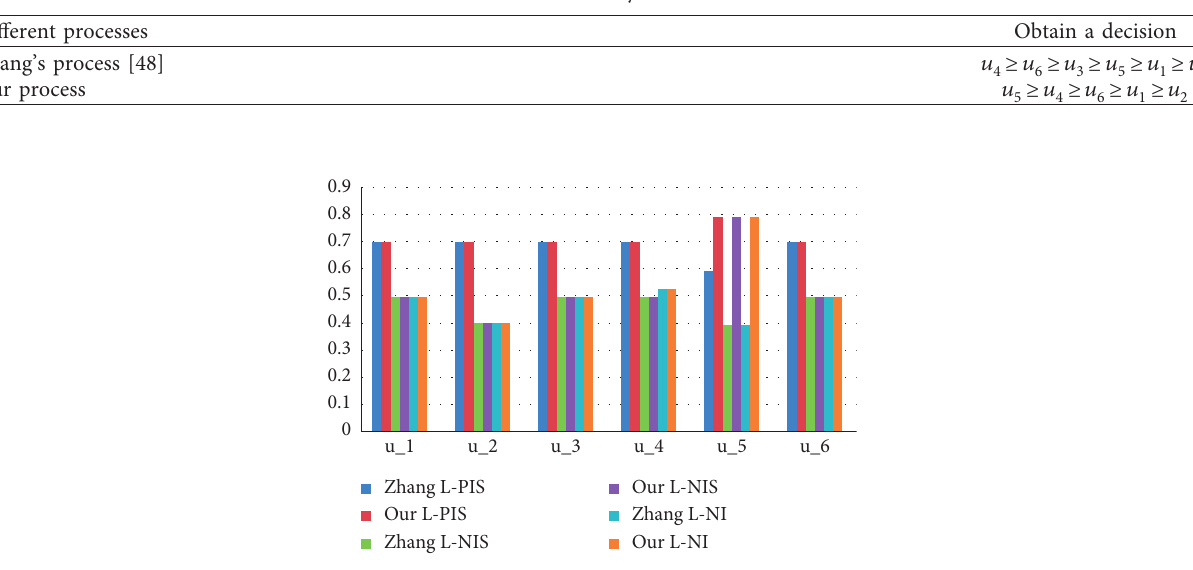
Table 18: Values by FCITFRS.